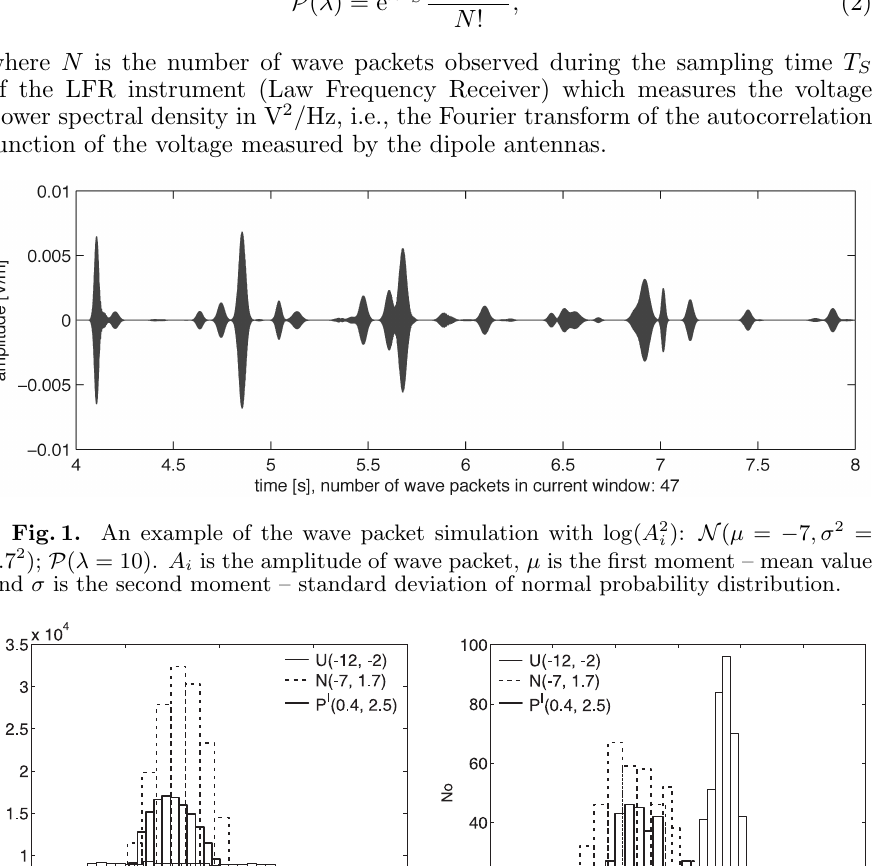
Fig. 2. Histograms of input wave pack- Fig. 3. Histograms of the Langmuir wave ets with amplitudes log( A 2 ): light gray power, log( P LW ), spectral domain. They i { U ( a = (cid:0) 12 ; b = (cid:0) 2), black { N ( (cid:22) = correspond to the input wave packet am- (cid:0) 7 ; (cid:27) 2 = 1 : 7 2 ), very light gray { P I ( (cid:22) = plitudes shown in Figure (cid:0) 0 : 5 ; (cid:27) 2 = 0 : 5 2 ; (cid:12) 1 = 0 : 4 ; (cid:12) 2 = 2 : 5); P ( (cid:21) = 10).